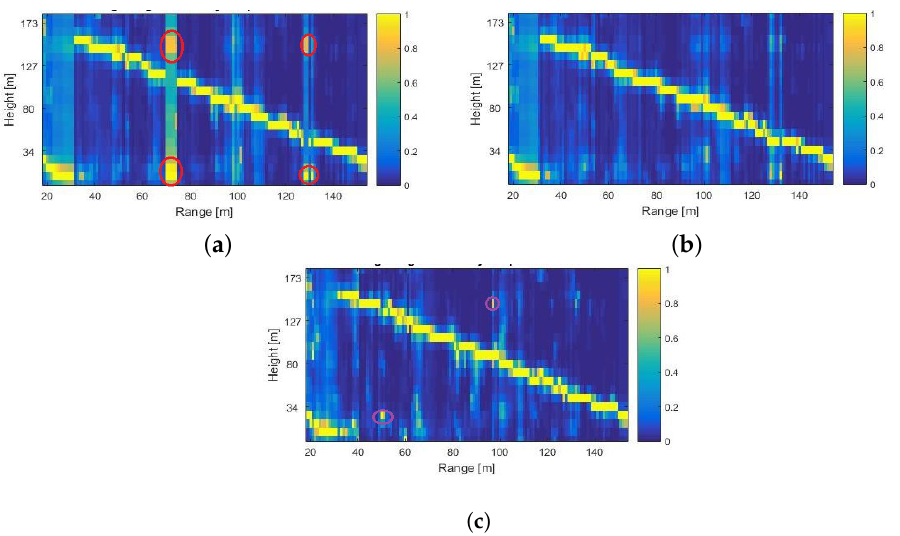
Figure 5. Generated tomograms using the proposed estimator with ( a ) 85%, ( b ) 90%, and ( c ) 95% thresholds.